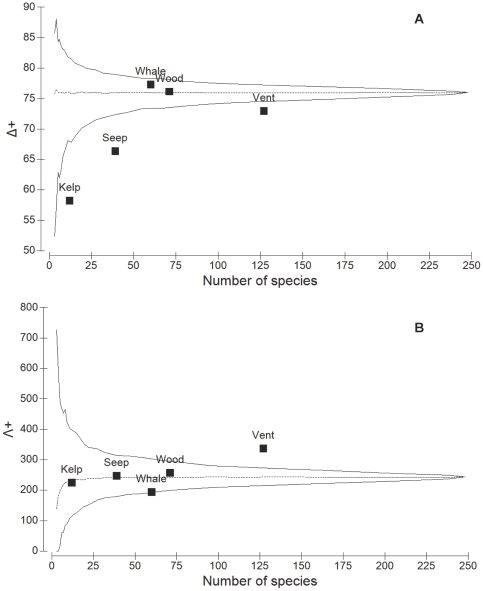
Taxonomic comparisons of the recruit assemblages among chemosynthetic habitats.(A) Average taxonomic distinctness (Δ+) and (B) variation in taxonomic distinctness (Λ+) for the recruit faunal lists from the five different chemosynthetic habitat types (Kelp, Seep, Vent, Whale, Wood) by numbers of species in each list. Dotted central line is (A) average taxonomic distinctness and (B) variation in taxonomic distinctness for the master list, generated from the full list of all chemosynthetic recruit fauna from all habitat types combined. Funnel (solid) lines are 95% simulated confidence limits for random selections of subsets of m species from the master list.